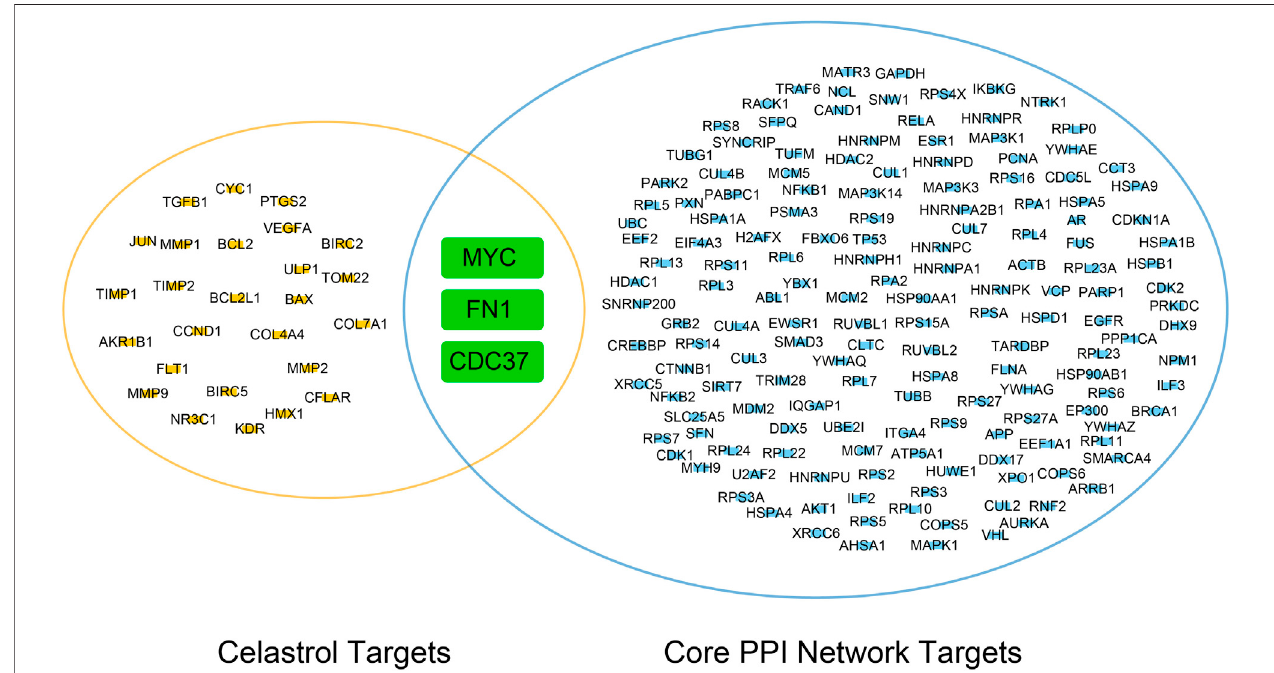
FIGURE 4 | Venn diagram of the core PPI network and celastrol targets. The core targets were MYC, FN1, and CDC37.